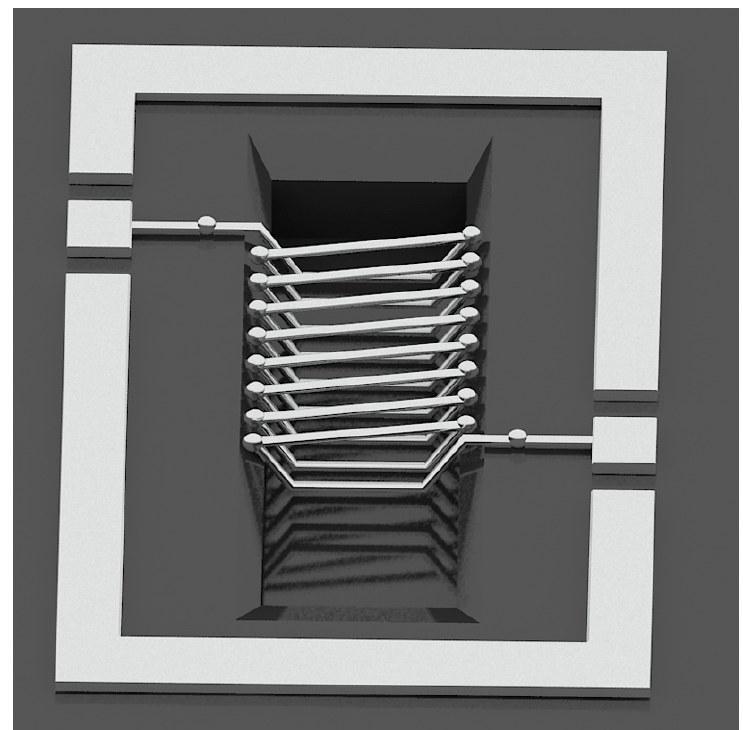
Figure 8. Structure of concave-suspended solenoid inductors. Table 2. Metal coils with different structures based on MEMS processing technology.